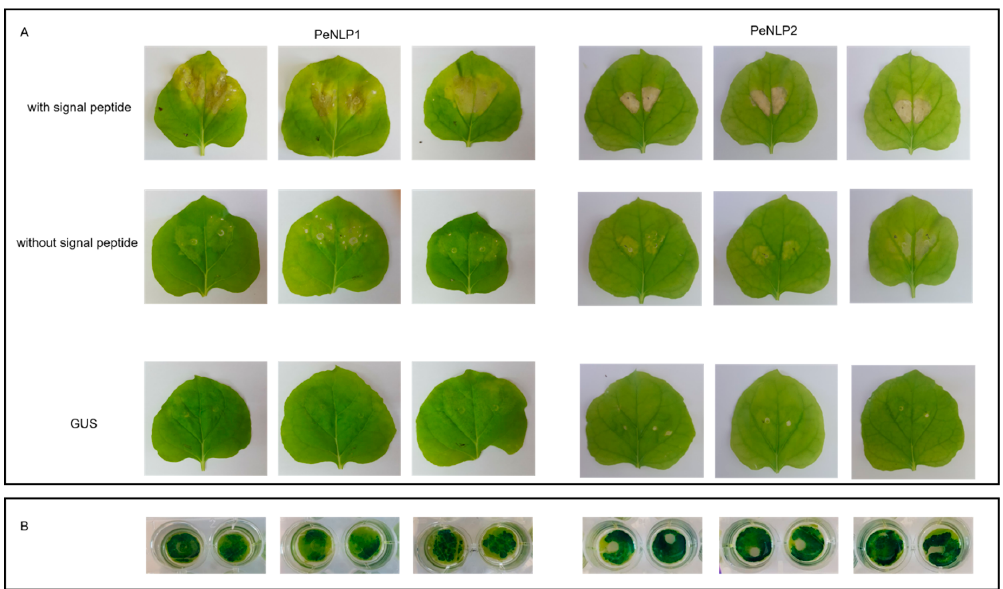
Figure 3. Expression of PeNLP1 and PeNLP2 induces cell death in N. benthamiana leaves. ( A ) Leaves of N. benthamiana infiltrated with constructs for constitutive expression of PeNLP1 (left panels) and PeNLP2 (right panels) and constutive expression of GUS as negative control. Pictures were taken 10 days post infiltration ( B ) Visualization of GUS activity indicates protein expression in the negative control.